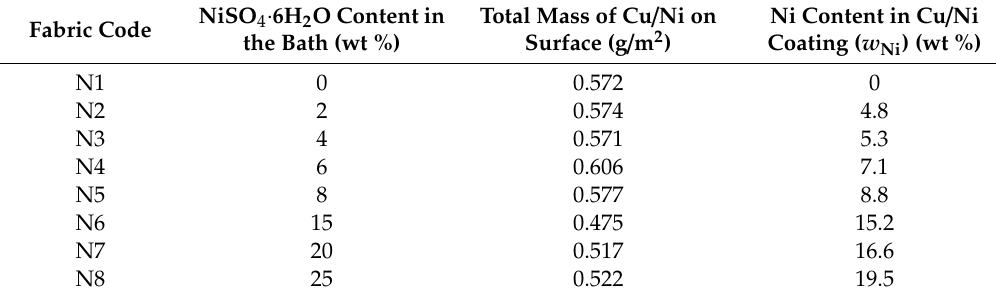
Table 1. Characteristics of the